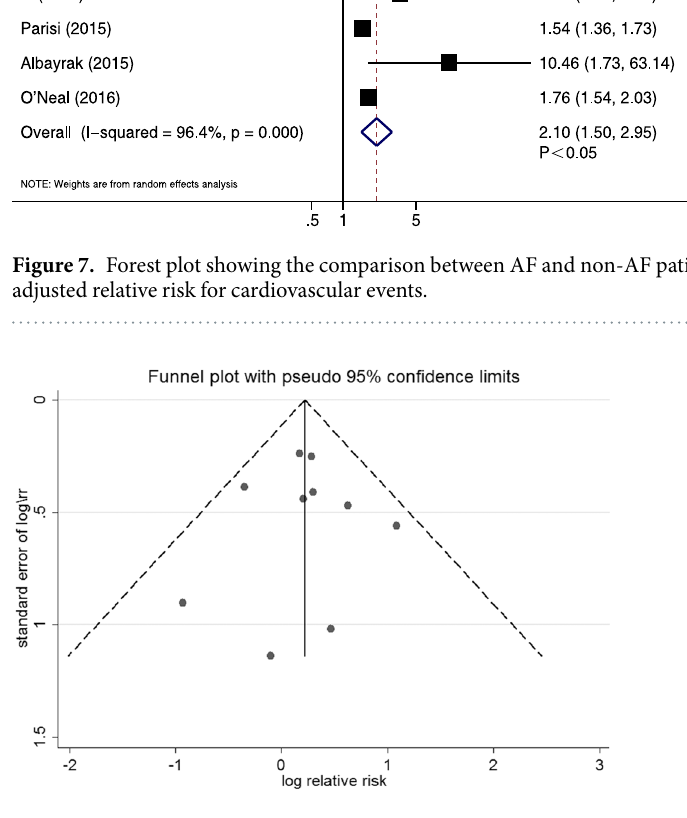
Figure 8. Funnel plot of studies assessing the myocardial infarction outcome.